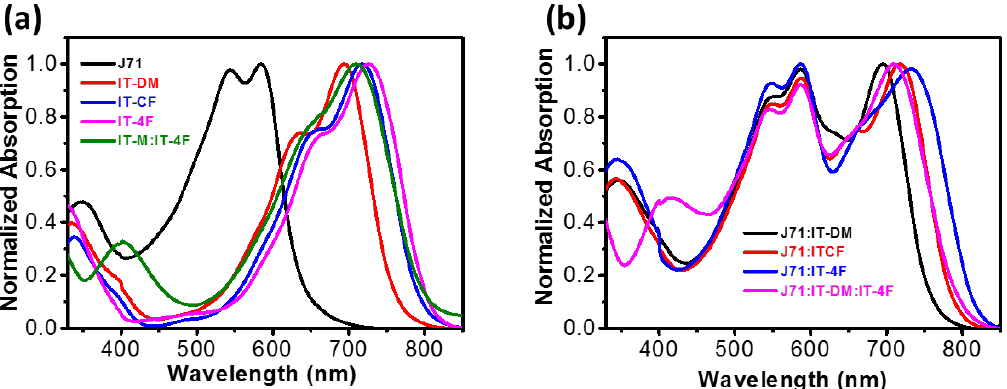
Figure 1. Normalized UV-vis absorption spectra of the films. ( a ) J71 film, acceptor films, and the IT-DM/IT-4F blend film; ( b ) Absorption spectra of the active blend Films. The data for pure IT-DM, IT-CF, IT-4F and for the binary blend of J71:IT-DM and J71:ITCF are used with permission from ref. [50]. Copyright (2019) American Chemical Society.